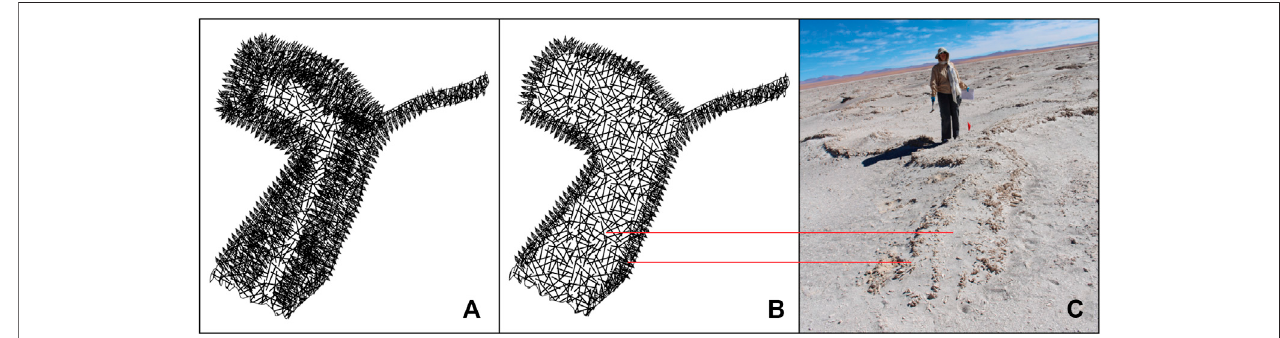
FIGURE4| Sketch ofintact ridge (A) and eroded ridge (B) . Intact ridges areshort segmentsofupwardly convex linearstructure withrough surfaces asde fi ned for domes and with an intact surface bed (roof), and ii) eroded ridges are de fi ned by two quasi-parallel, sinuous lines of randomly oriented spines of similar length ( < 18 cm) between which are areas of mixed regolith. (C) Image of eroded ridge showing branching form. Person for scale.